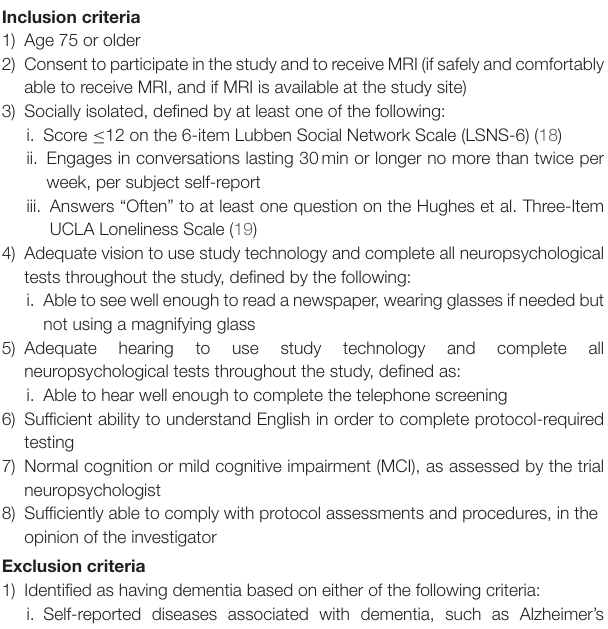
TABLE 1 | Inclusion and exclusion